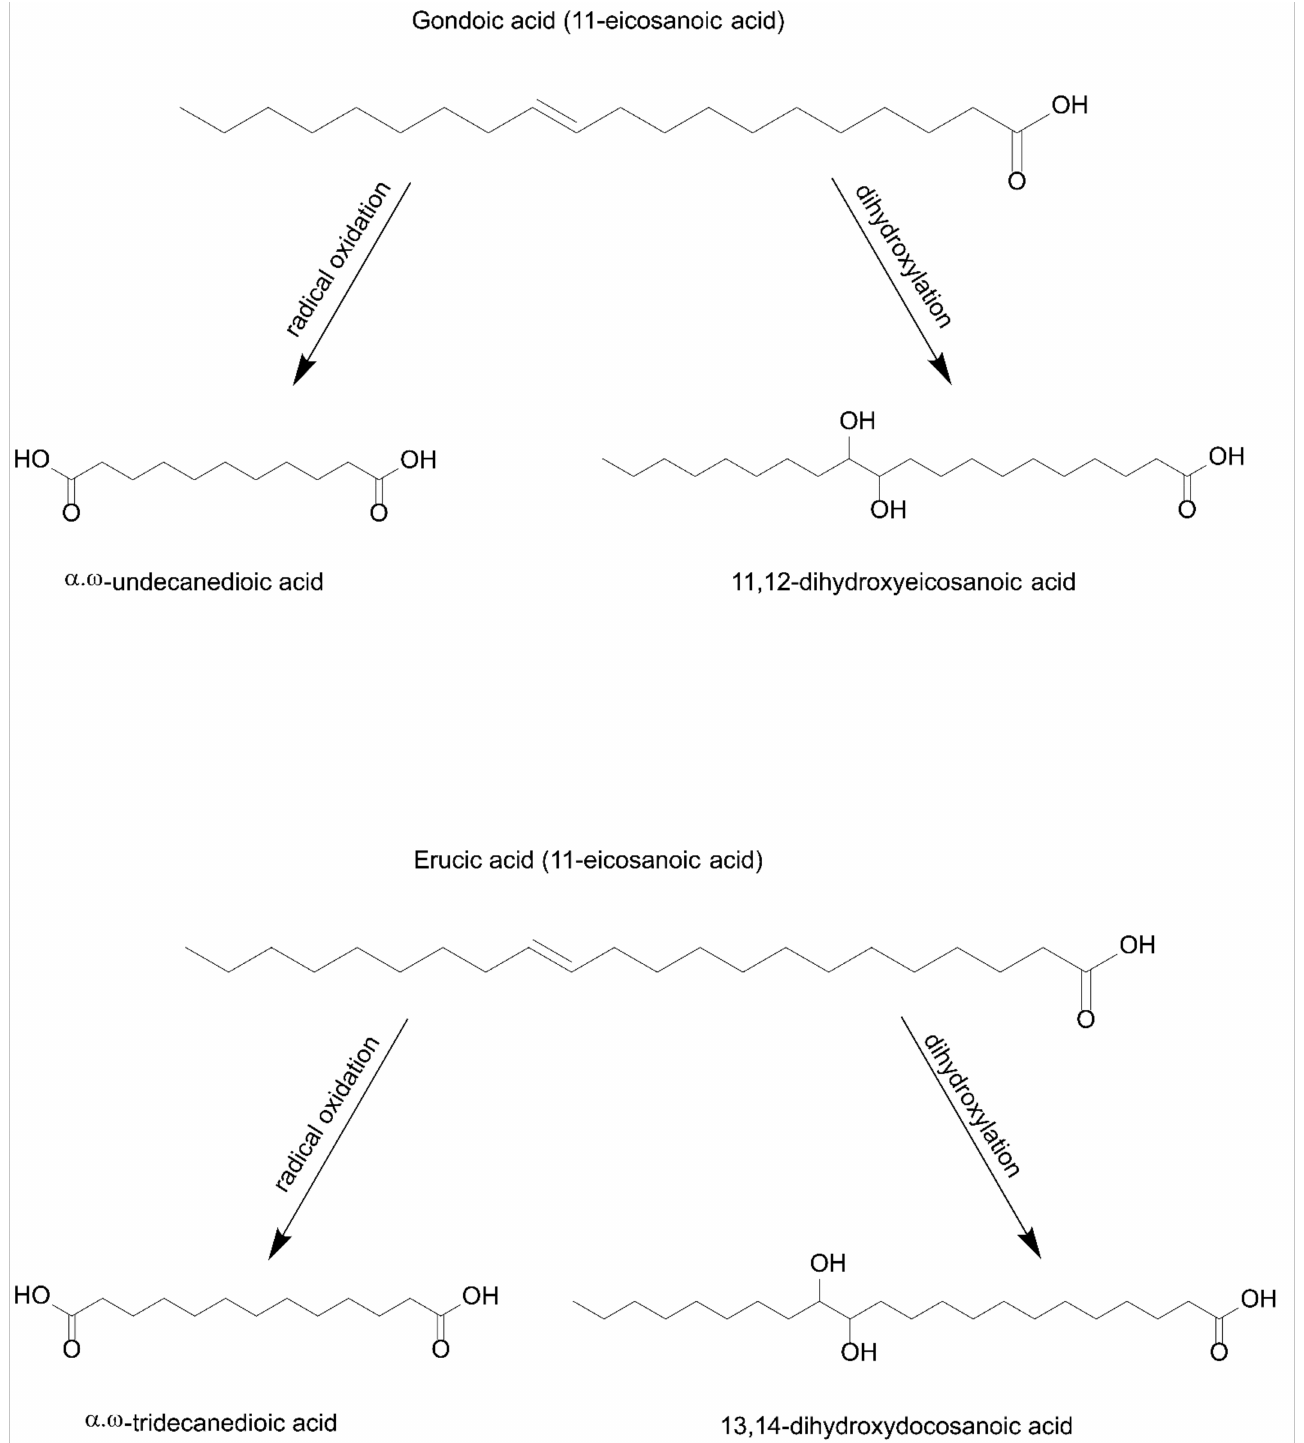
Figure 3. Degradation/alteration pathways of gondoic and erucic